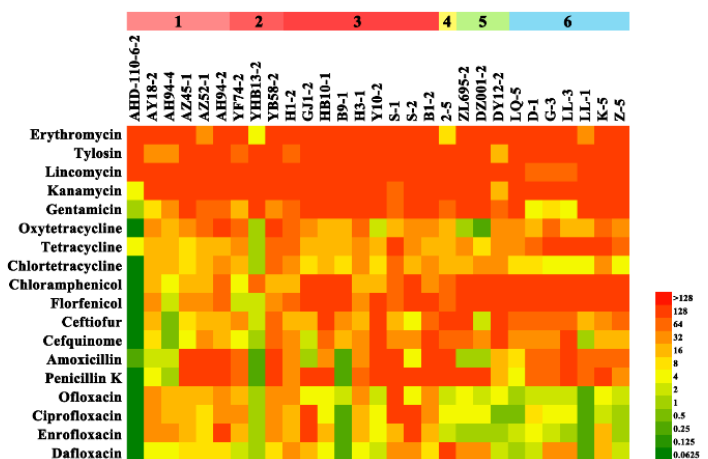
Figure 3. The MIC results of 29 clinical isolates of S. suis . The MIC value is represented by a color scale (top right) going from low (green) to high (red).